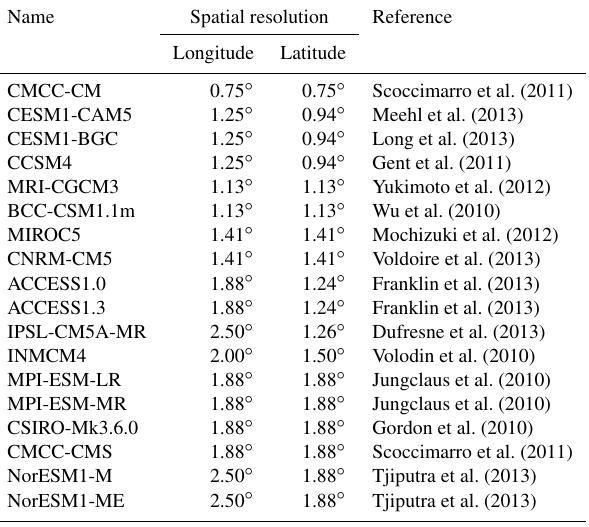
Table 1. Summary of the CMIP5 surface downward radiation sim- ulations used in this